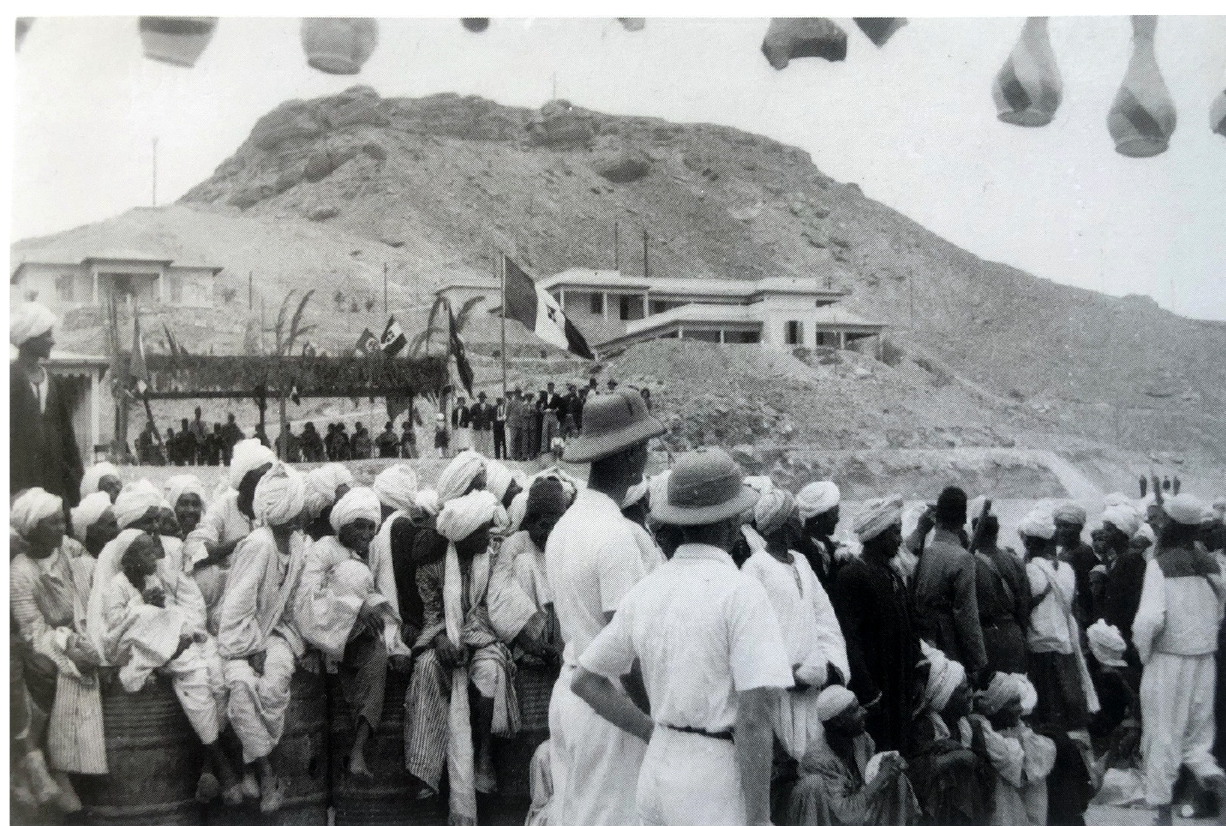
Figure 8. Egyptian and Italian company workers enjoying festivities at the desert plant. Source: Pellegrini (2011, p.